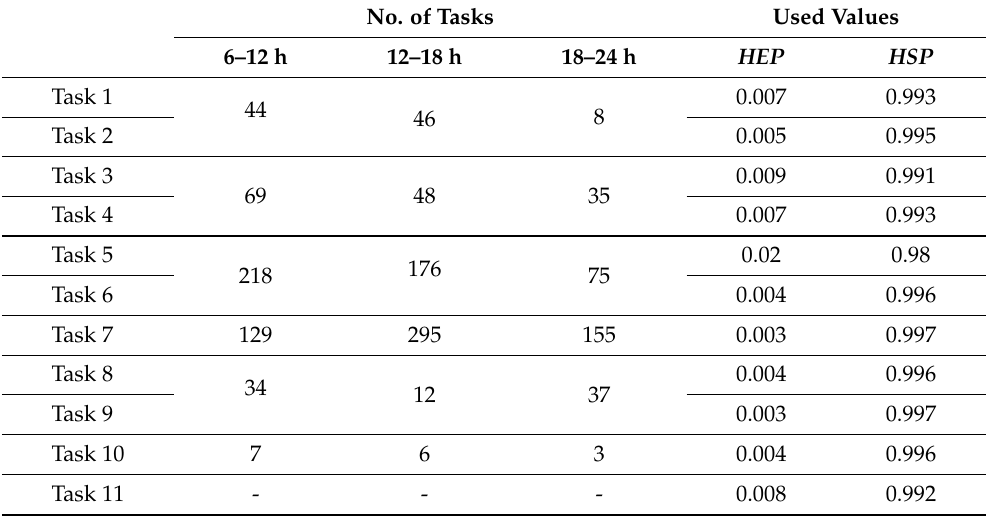
Table 15. Final overview of workplace C. No. of Tasks Used